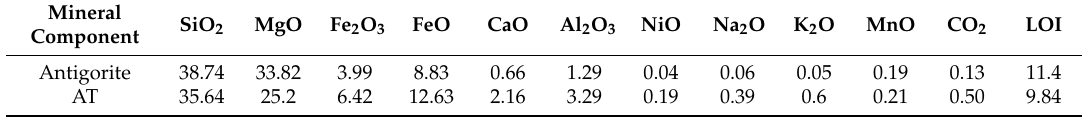
Table 1. Chemical composition of antigorite and antigorite-containing ore dressing tailings (AT) (wt. %). Mineral SiO 2 Component